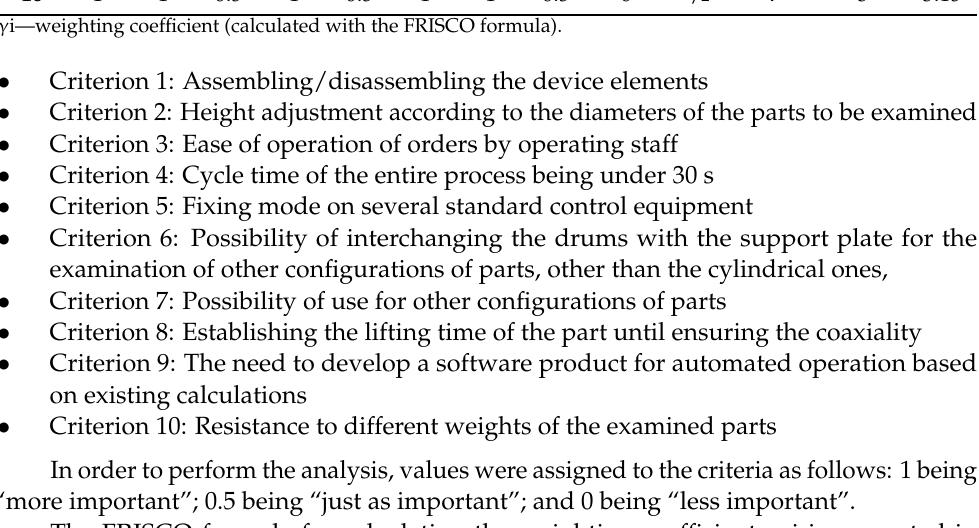
Table 3. Multicriteria analysis.